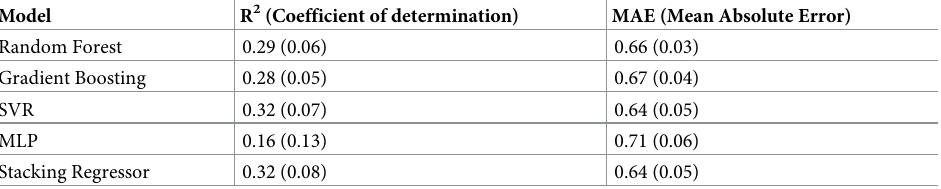
Table 5. 5-fold cross-validation performance of different machine learning models on training dataset for males. Model